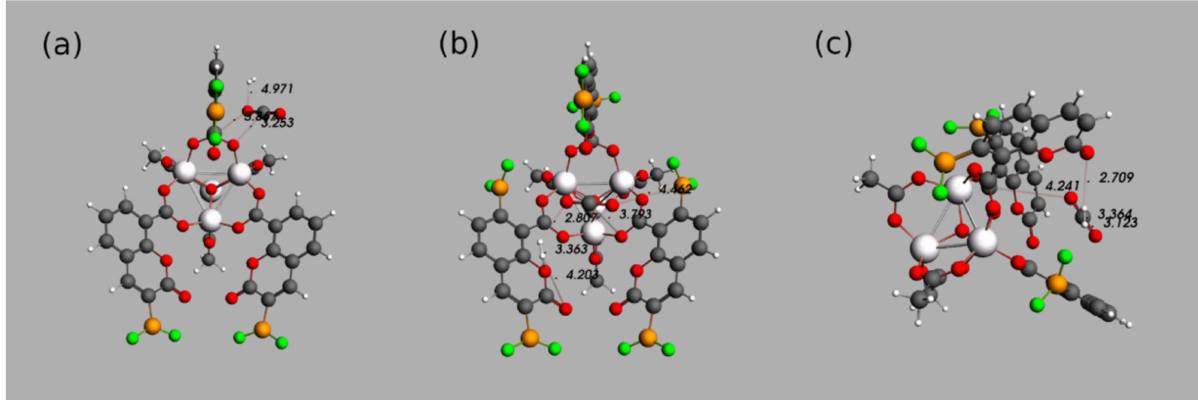
Figure 5. Comparison between the optimized geometries for the calculation of the excited states of the primitive cells ( a ) IRMOF-C-BF 2 , ( b ) IRMOF-C-(2)-BF 2 y ( c ) IRMOF-C’-BF 2 , in the presence of H 2 and CO 2 . The distances specified are shown in Angstroms (Å). Coordinates in xyz format available in the the Supplementary Materials (Table